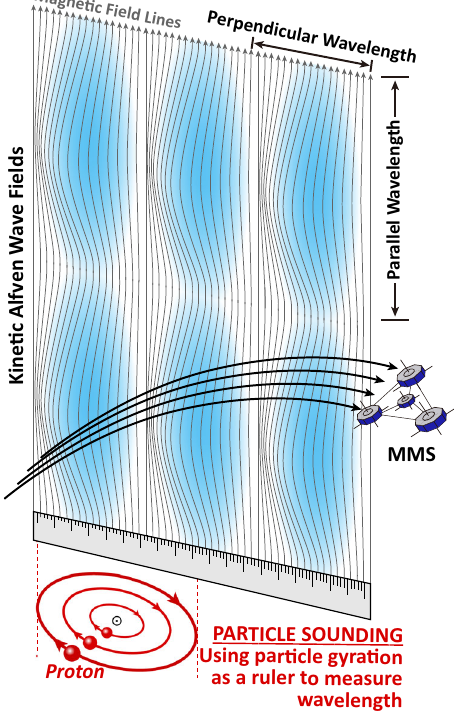
Fig. 1 | Schematics of particle-sounding technique (not to scale). The thin grey curvesrepresentthe magnetic fi eldlines.Theblue background showsthephaseof KAWs. The red curves at the bottom illustrate the gyration of protons of different energy in the magnetic fi eld. The interactions between KAWs and protons would signi fi cantly modulate the distribution function of protons, which can then be observed by the MMS spacecraft. This observation, in turn, provides a “ ruler ” to derive the perpendicular wavelength of the